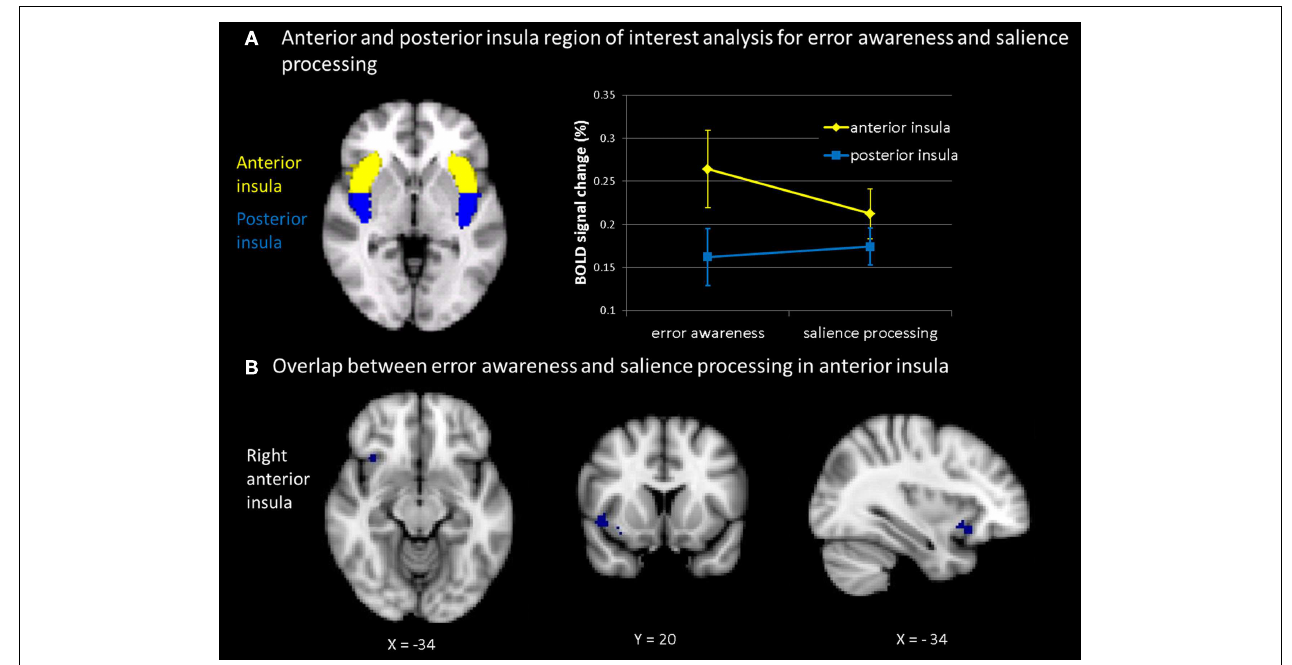
than in the posterior insula.The main effect of task indicated no differences in percent signal change in the insula between error awareness and the processing of motivationally significant events (B) : plotted overlap in the anterior insula within subjects across tasks (for the contrast aware errors as compared to unaware errors; and for the contrast of salience processing, i.e., linear signal increase across inter-target interval).